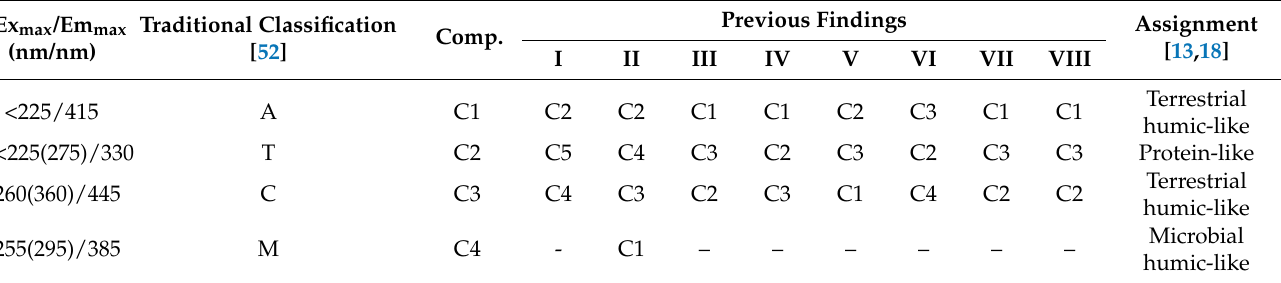
Table 3. Comparing the four components at different Ex/Em peak locations from different classifications with those in existing literature.